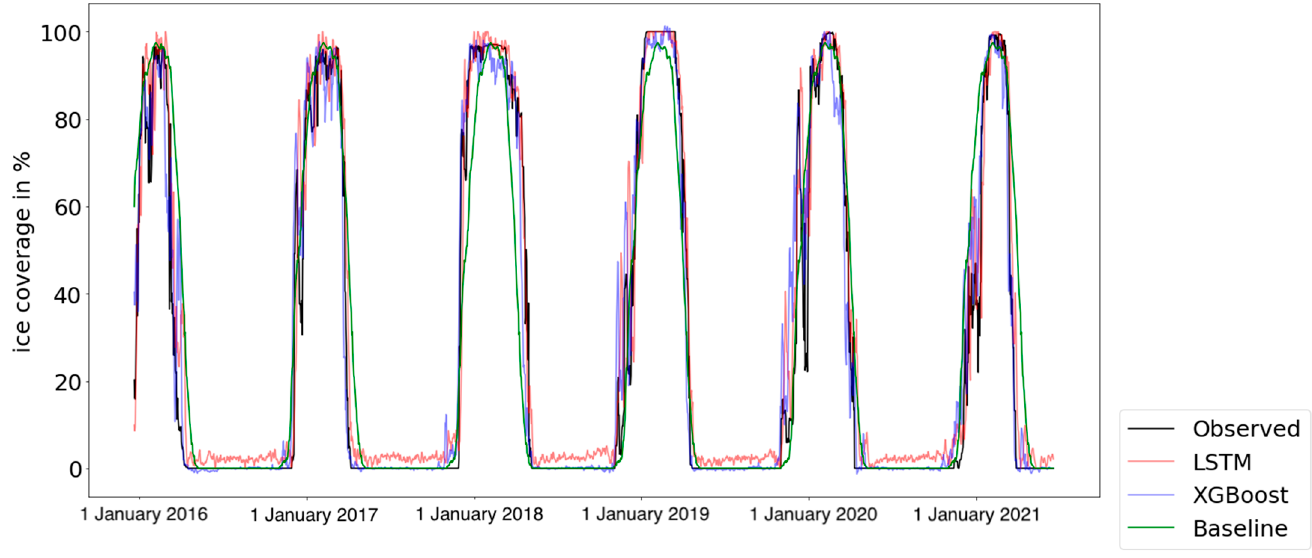
Figure 6. Time series of the ice coverage over the St. Marys River system for 7-day predictions. According to this time series plot, the blue curve (LSTM) and the red curve (XGBoost) overlap with the black curve for most of the time, except in December and April for each year. During these two months, we can see that the black curve (observation) contains some small fluctuations, which indicates that the ice value varies dramatically in a short period. The red curve (LSTM) and the blue curve (XGBoost) both divert from the black curve (observation), indicating that the models have less skills in these two months. The fluctuations in these periods may be caused by a drastic change in the local air